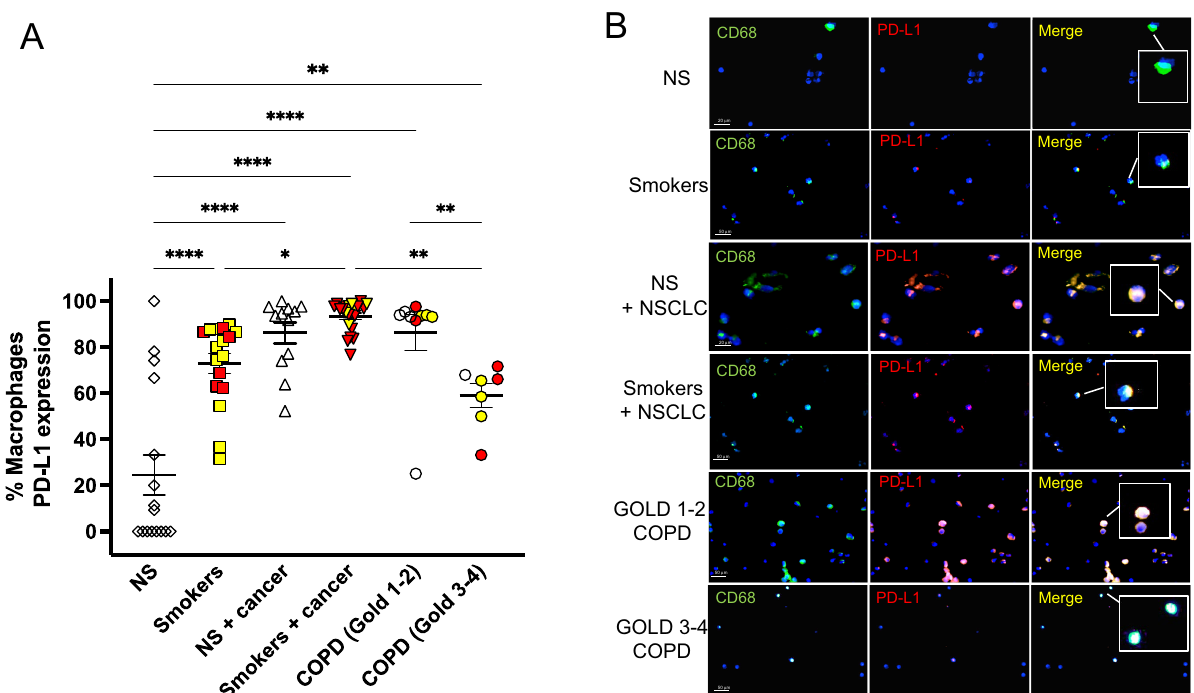
Figure 7. Similar PD-L1 expression in AMs from patients with GOLD 1–2 COPD and patients with NSCLC. Immunofluorescence analysis of PD-L1 expression by bronchoalveolar lavage (BAL) AMs from Cohort 2. ( A ) empty symbols represent never-smokers (NS); yellow symbols represent subjects who stopped smoking > 1 year prior to the study; red symbols represent current smokers at the time of the study. ( B ) representative immunofluorescence pictures showing CD68+ (green, as a marker of macrophages) and PD-L1+ (red) cells in bronchoalveolar lavage from all the cohort 2 study subjects. Nuclear DNA was labeled with DAPI (blue). Confocal microscopy was performed with 60X and 100X objectives. The insets show CD68 + alveolar macrophages (AMs) that were positive (NS + NSCLC, smokers + NSCLC, and GOLD 1–2 COPD) or negative (NS, smokers, GOLD 3–4 COPD) for PD-L1.